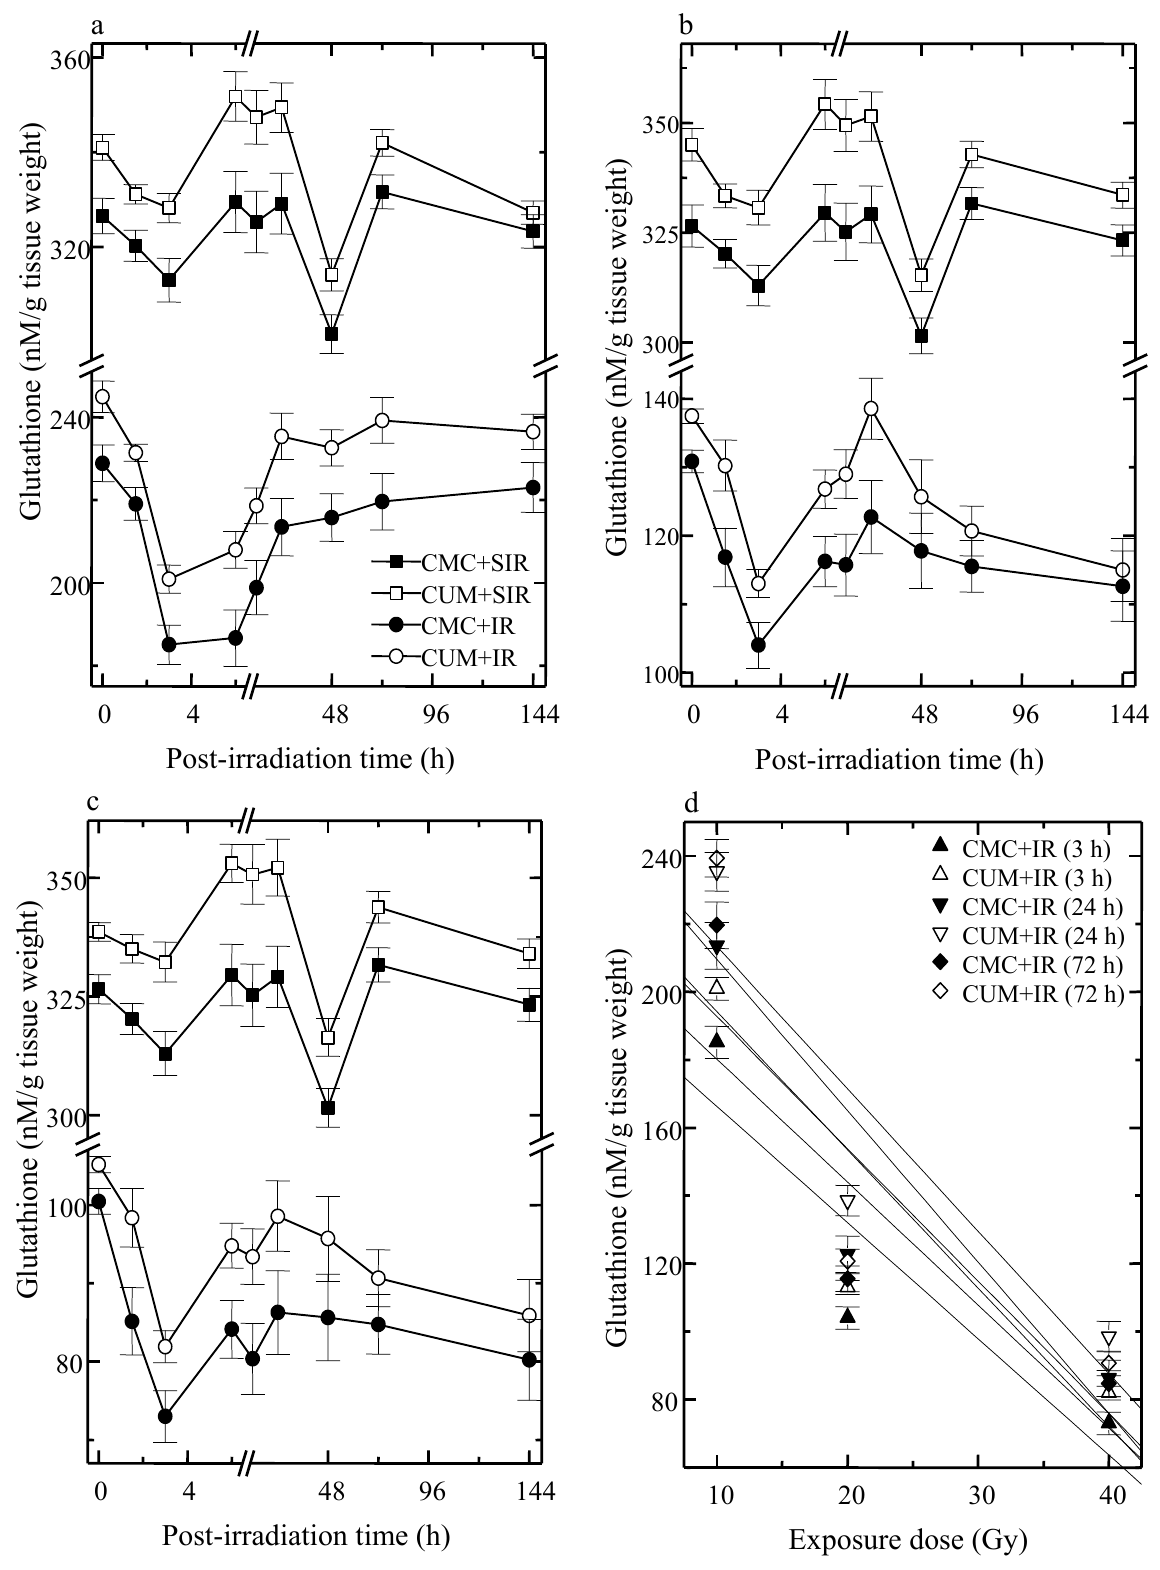
Figure 1. Effect of curcumin on glutathione concentration in the skin of mice exposed to fractionated doses of γ-radiation. ( a ) 10 Gy ( b ) 20 Gy ( c ) 40 Gy and ( d ) dose response